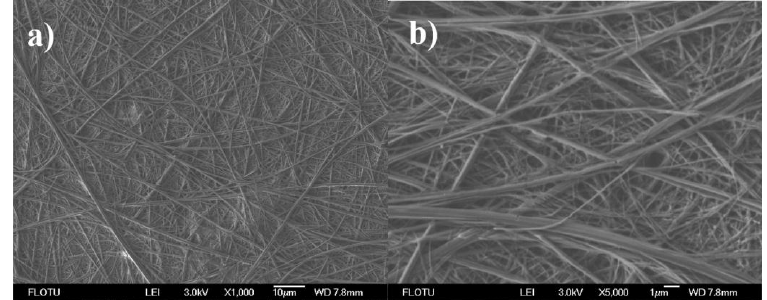
Figure 4. SEM images of aLGN nanocomposites.